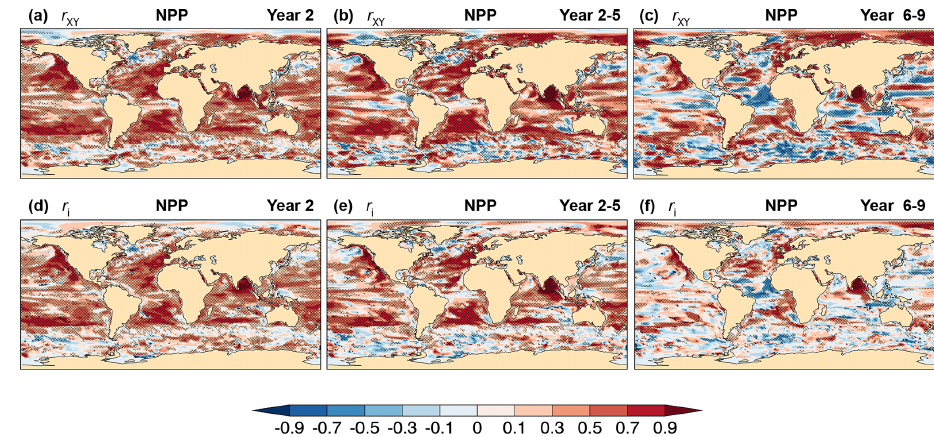
Figure 19. Potential for skill of CanESM5 annual and multi-year mean of ocean NPP hindcasts. (a–c) Correlation skill r XY , Eq. (6), with the assimilation runs as verifying observations, and (d–f) contribution from initialization r i to correlation skill, Eq. (A17), for (a, d) Year 2, (b, e) Year 2–5, and (c, f) Year 6–9 hindcasts. The CanESM5 assimilation runs used as verifying observations provide the initial conditions of the hindcasts. Cross-hatched regions indicate values significantly different from zero at the 90% confidence level.